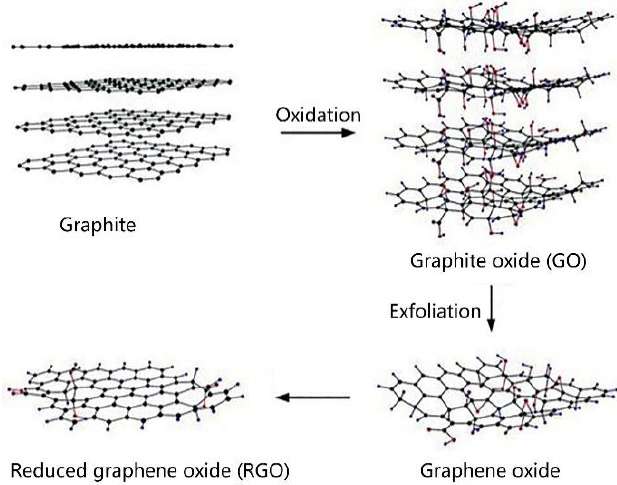
Figure 1. Preparation of graphene by chemical reduction of graphene oxide synthesized by Hummers’ method. Reprinted with permission from [61]. Copyright 2011, Wiley-VCH.